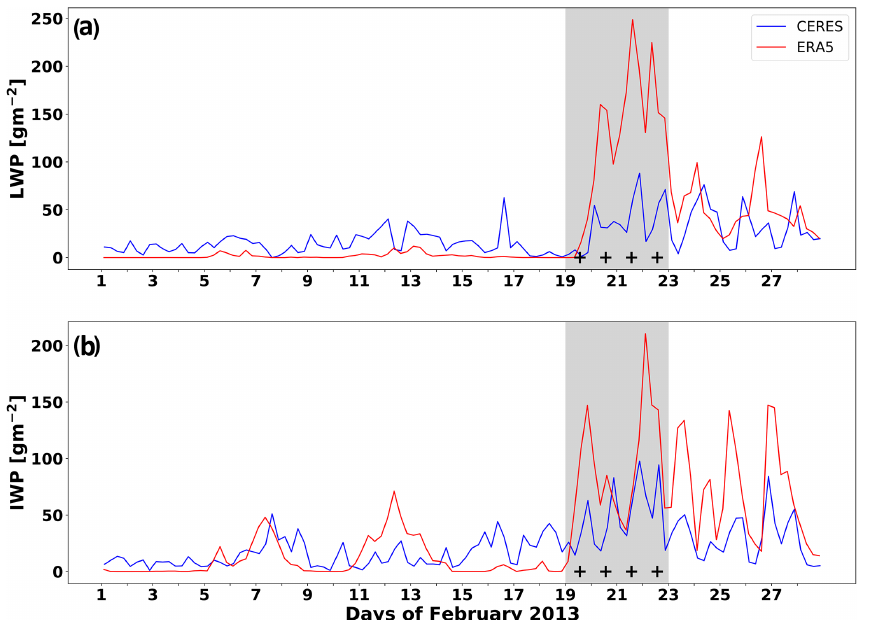
Figure 13. As in Fig. 5 but over the Pine Island and Thwaites Glacier region throughout February 2013.